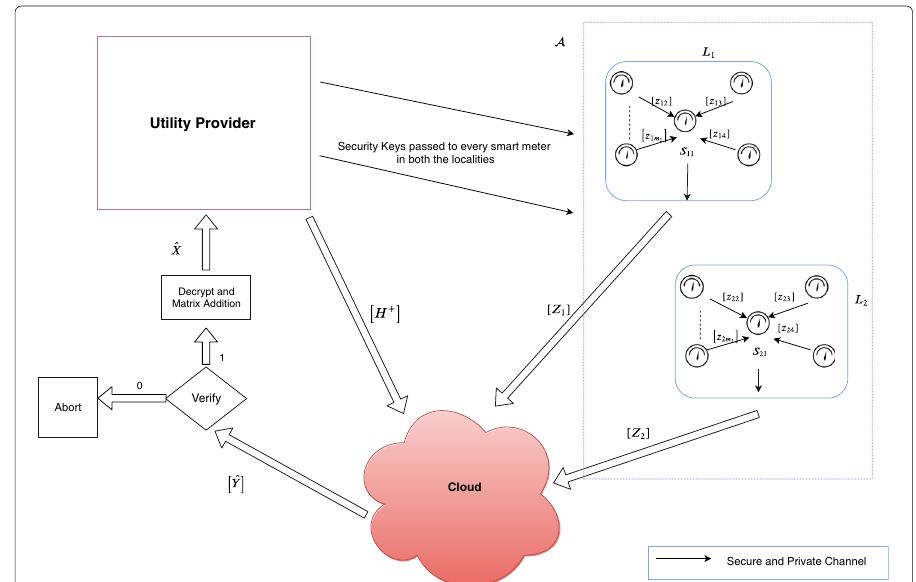
Fig. 1 Proposed solution